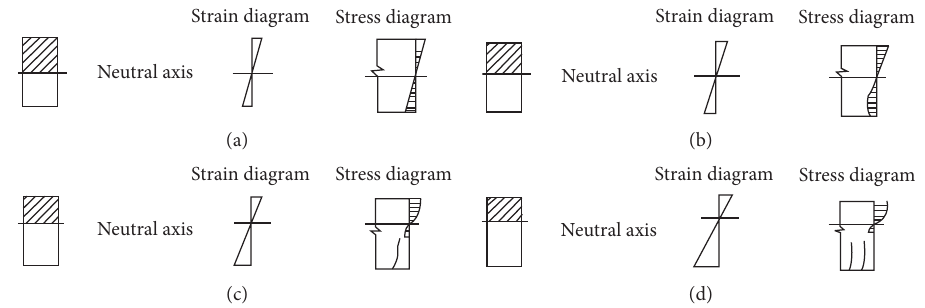
Figure 8: The mechanical characteristic of normal section of thin immediate roof under uniform